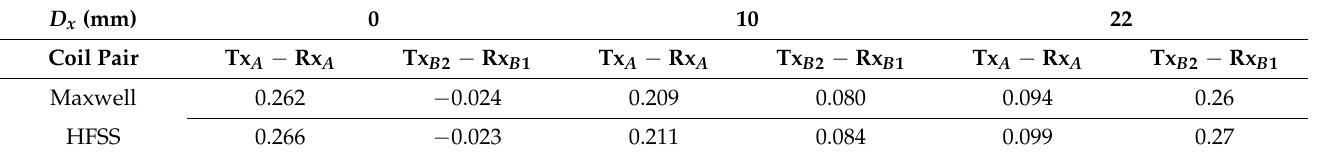
Table 2. Calculated coupling coefficients for various misalignment states.